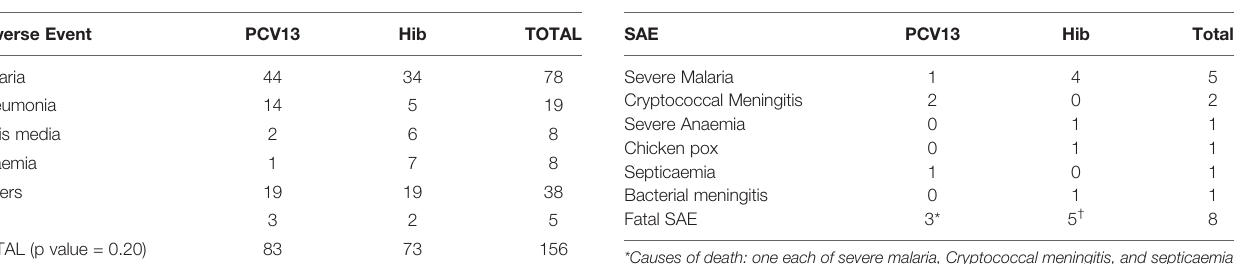
TABLE 4 | Unsolicited adverse events per study arm.